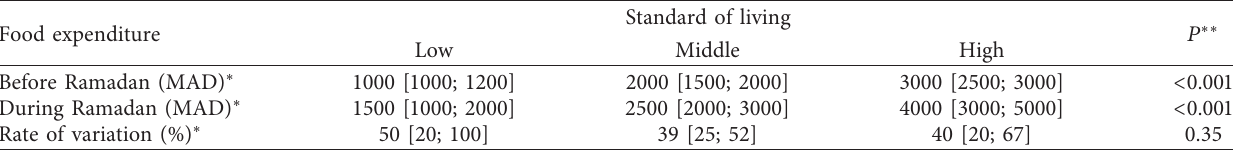
Table 2: Food expenditure before and during Ramadan according to standard of living ( n � 340).